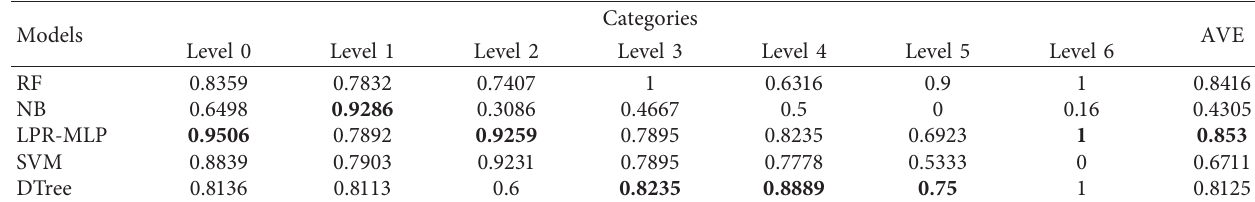
Table 4: Precision of all